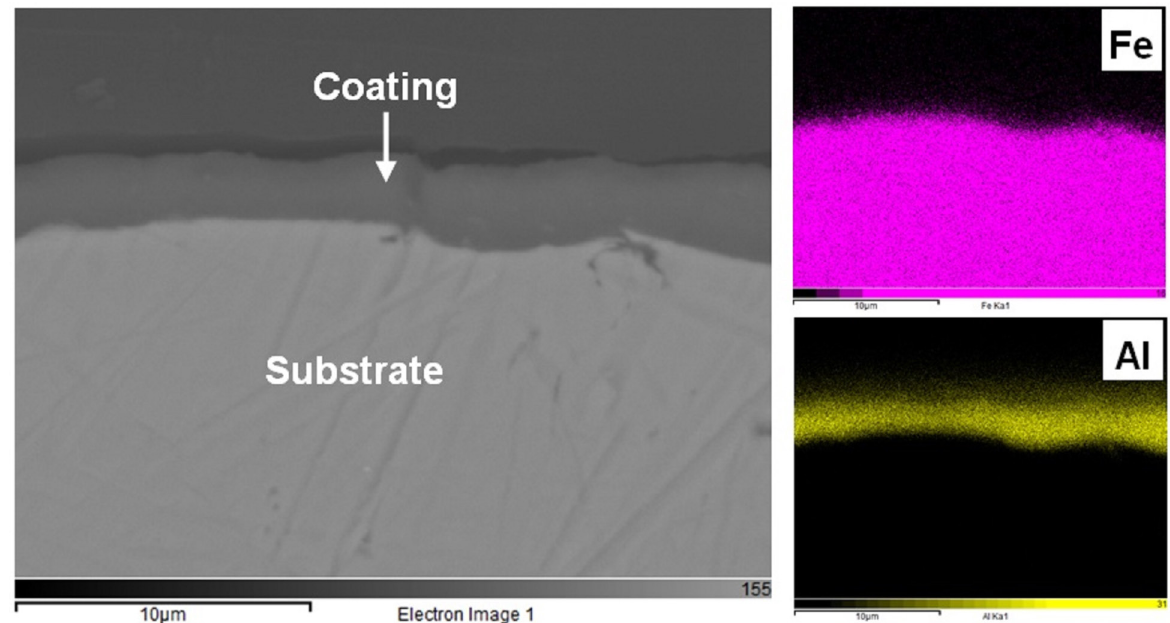
Figure 3. EDX elemental mapping of Al coating on low-carbon